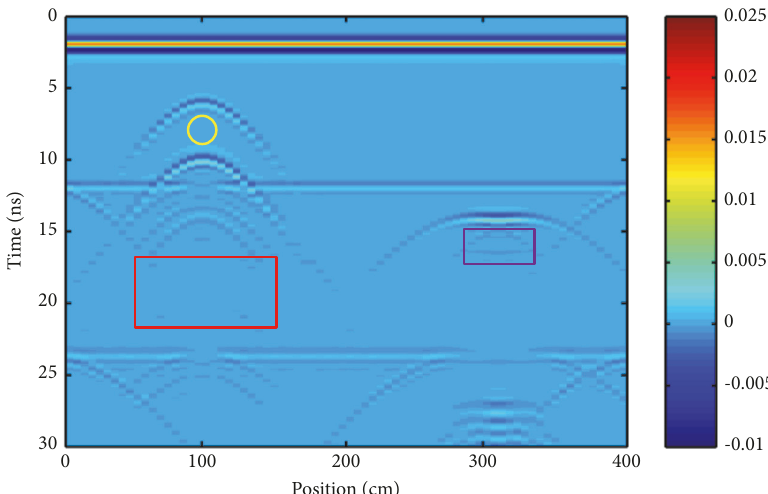
Figure 15: The wiggle trace profile of the three-layer pavement model simulated by the CUDA-implemented conformal SPRK methods.